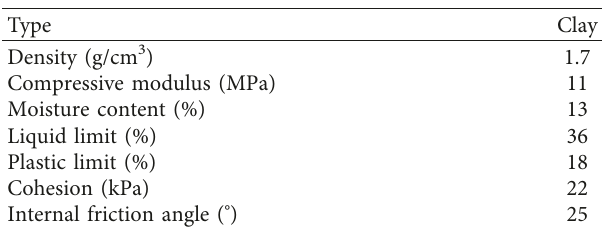
Figure 3: (a) Ring knife tests; (b) oedometer tests; (c) moisture content tests; (d) liquid limit and plastic limit tests; (e) direct shear Table 1: Physical properties of clay.